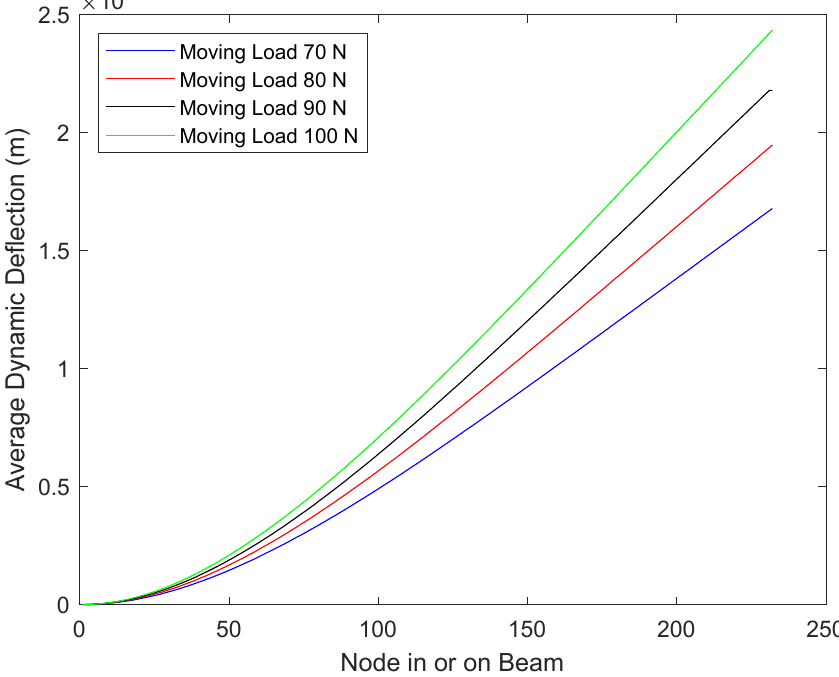
Figure 10. Average Dynamic Deflection of Cracked Beam (crack at x/l = 0.50) under moving load.